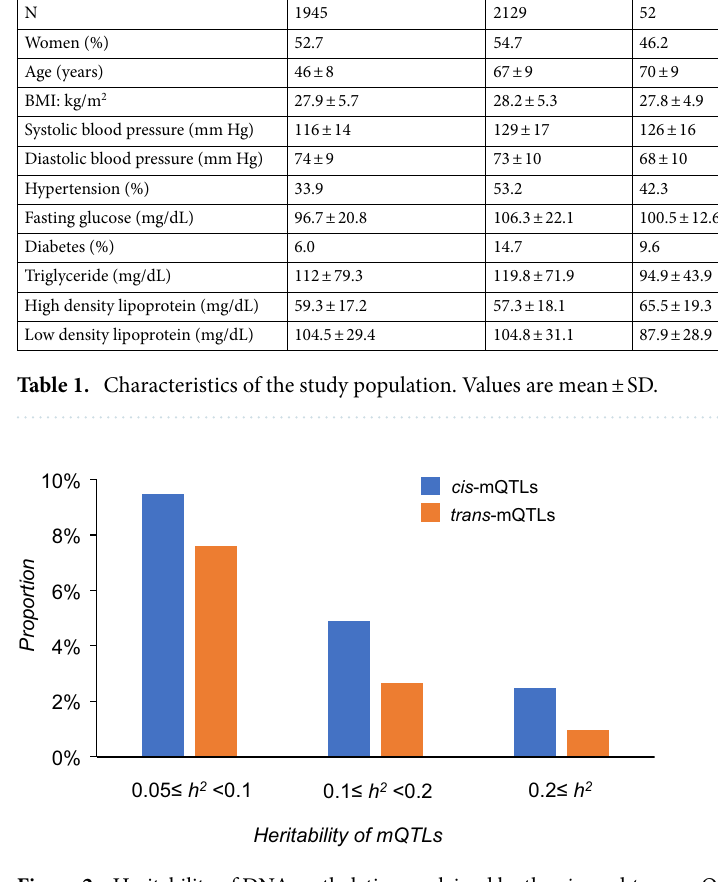
Figure 2. Heritability of DNA methylation explained by the cis - and trans -mQTLs identified in the pooled analysis. The total number of cis -mQTLs is 94,362,817 and the total number of trans -mQTLs is